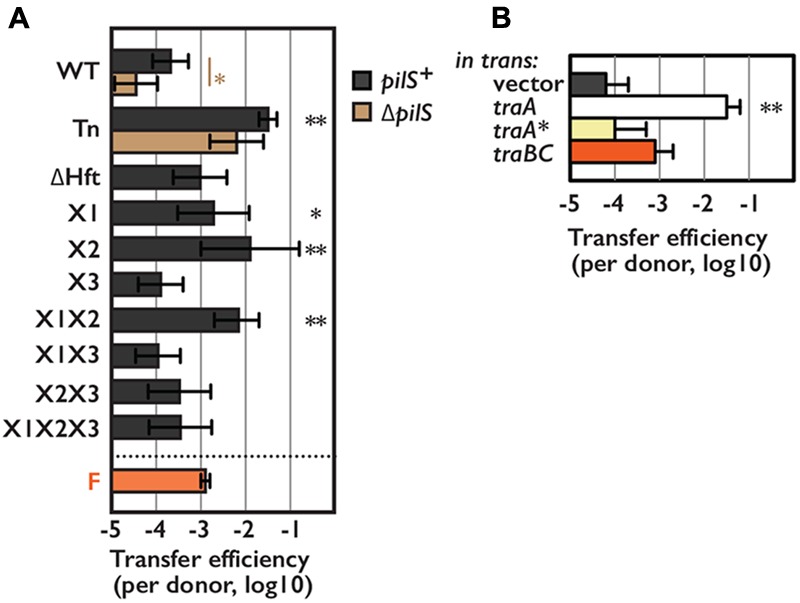
Transfer efficiency of pESBL in snap conjugation. Transfer efficiencies of various pESBL variants (A) or WT pESBL harboring an extra plasmid for overexpression of indicated gene (B). F plasmid was used for comparison. Average and standard deviation of at least 3 independent experiments were shown. ∗Indicates p < 0.05 and ∗∗ indicates p < 0.01, respectively.